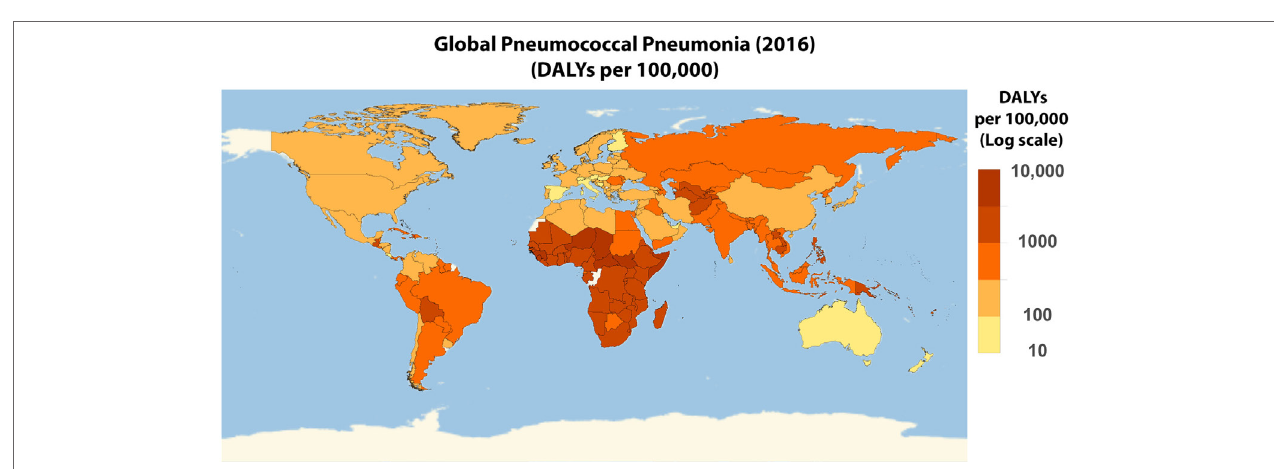
FigURe 5 | Worldwide disability adjusted life year (DALY) of pneumococcal pneumonia. Global distribution of pneumococcal pneumonia on a log10 scale of the 2016 DALY per 100,000 pneumococcal pneumonia data obtained from Institute for Health Metrics and Evaluation (7).